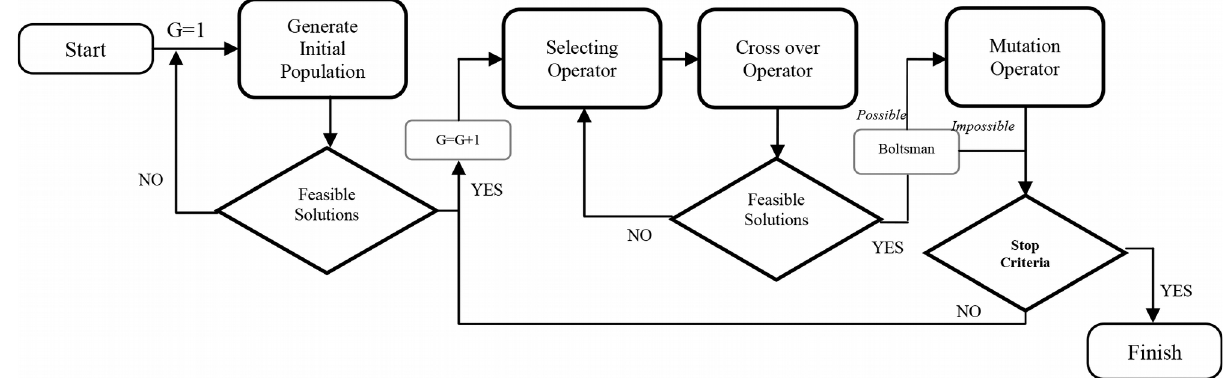
Figure 3. Structure of the proposed GA to solve CMS